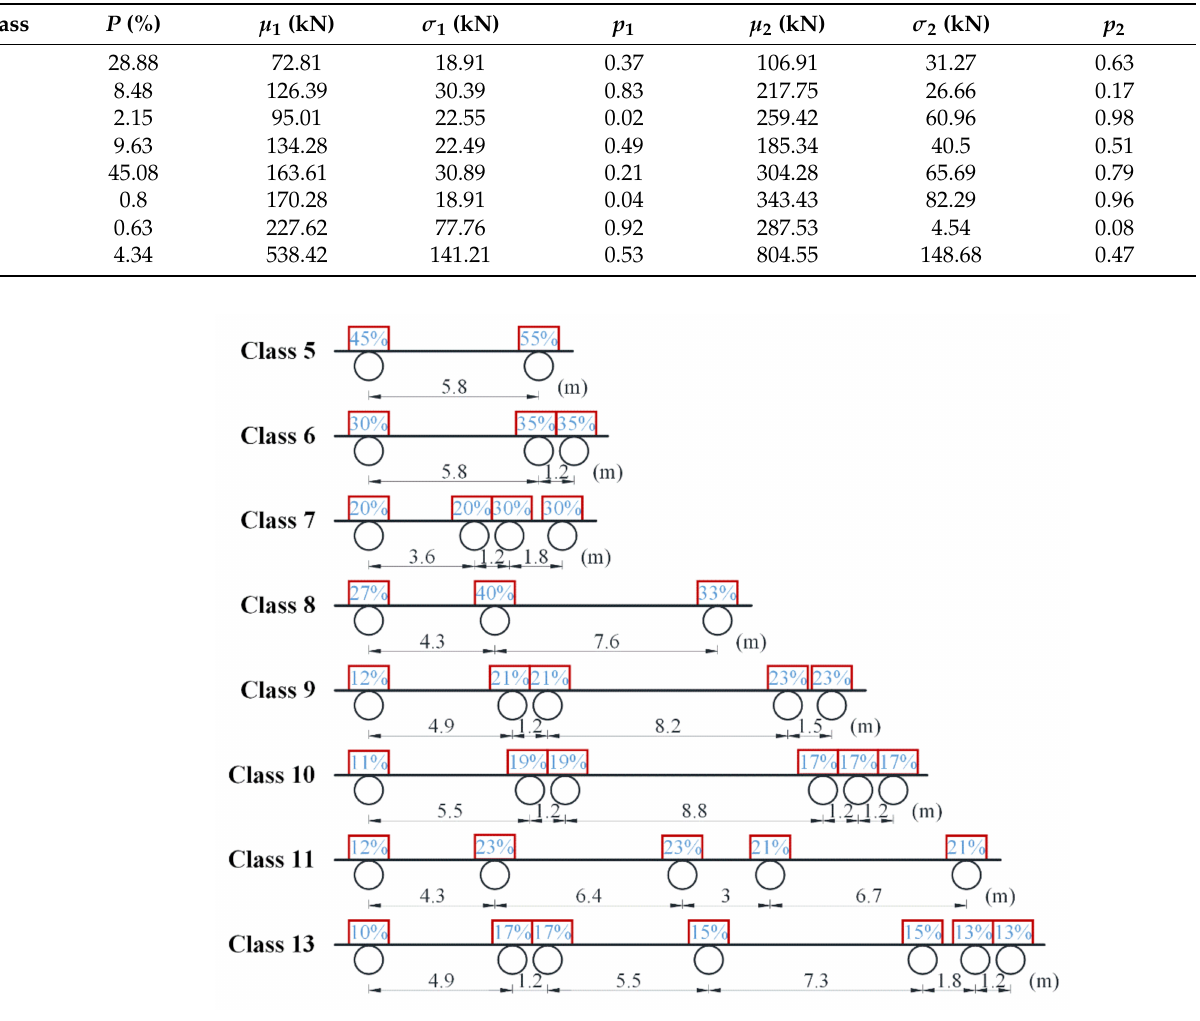
Figure 6. The axle weight ratio and the mean axle spacing of truck